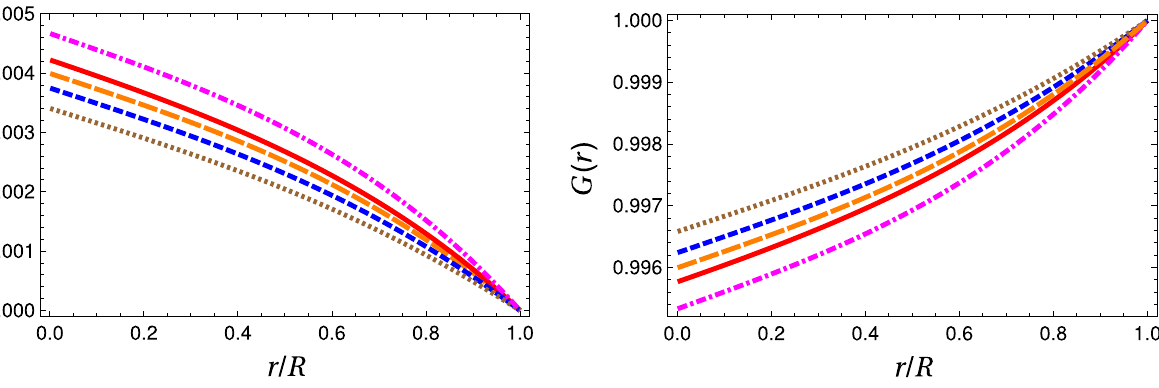
Fig. 4 Running (r-varying) Newton’s constant vs dimensionless radial coordinate r / R for the five plus five interior solutions obtained here. Left: Solutions 1–5 corresponding to the case G (cid:5) ( r = 0 ) = − 0 . 0002 / km (Table 1). Shown are: (i) Solution 1 (solid red line), (ii)